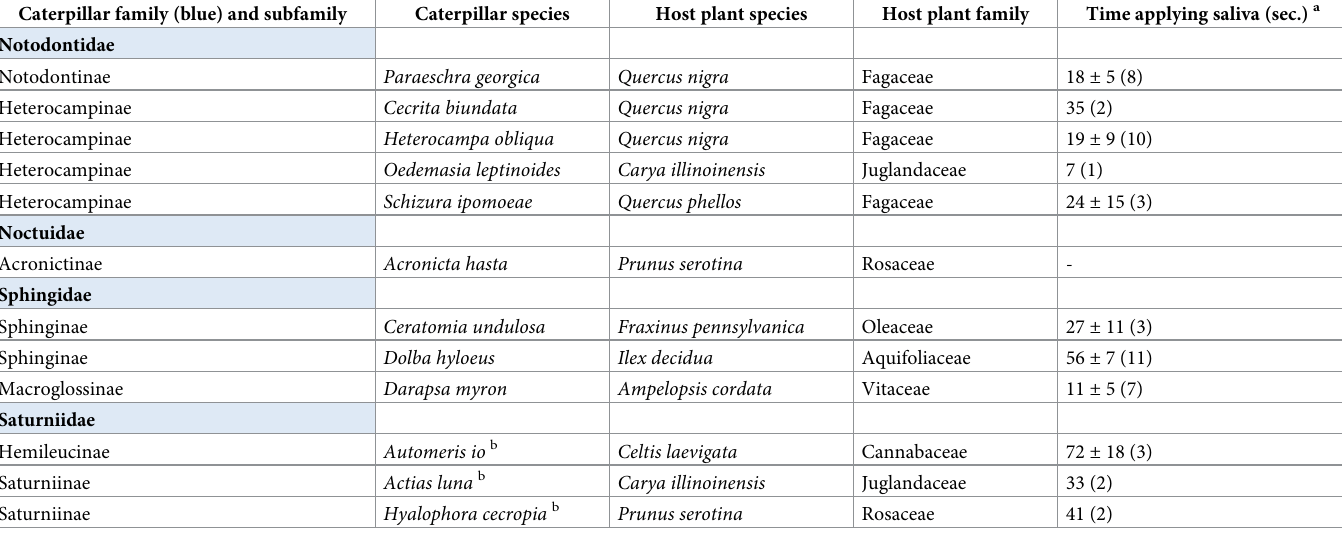
All data are for final instar caterpillars unless indicated otherwise. a means ± s.e., number of replicates (movie clips) is shown in parentheses. b penultimate